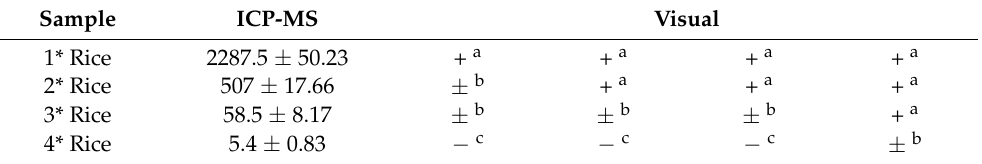
Table 3. Analysis of mercury in true samples by the ICA strip assay (n = 4).